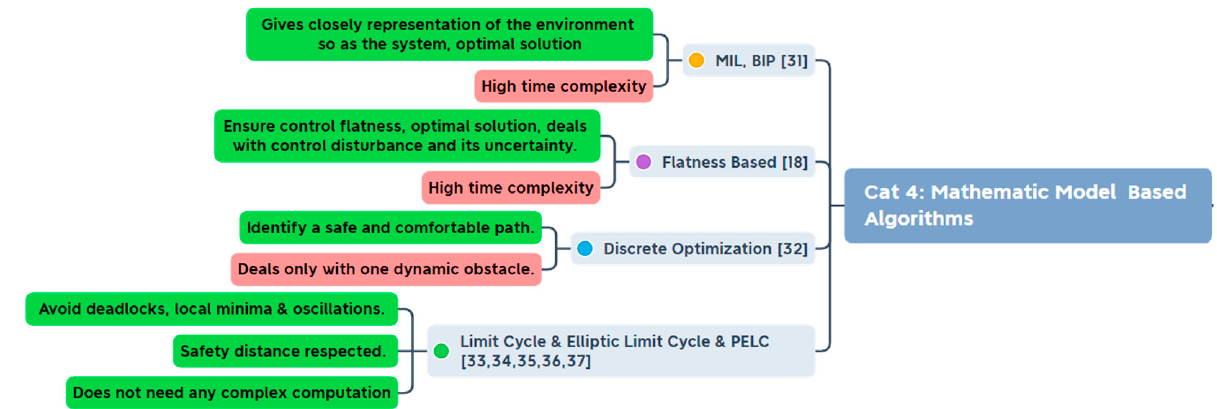
Figure 5. Mathematic model-based approaches with the main advantages and drawbacks.